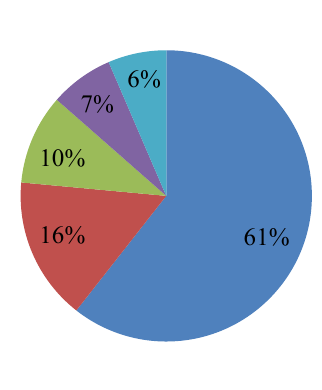
Fig. 2. Percentage distribution of respondents based on level of